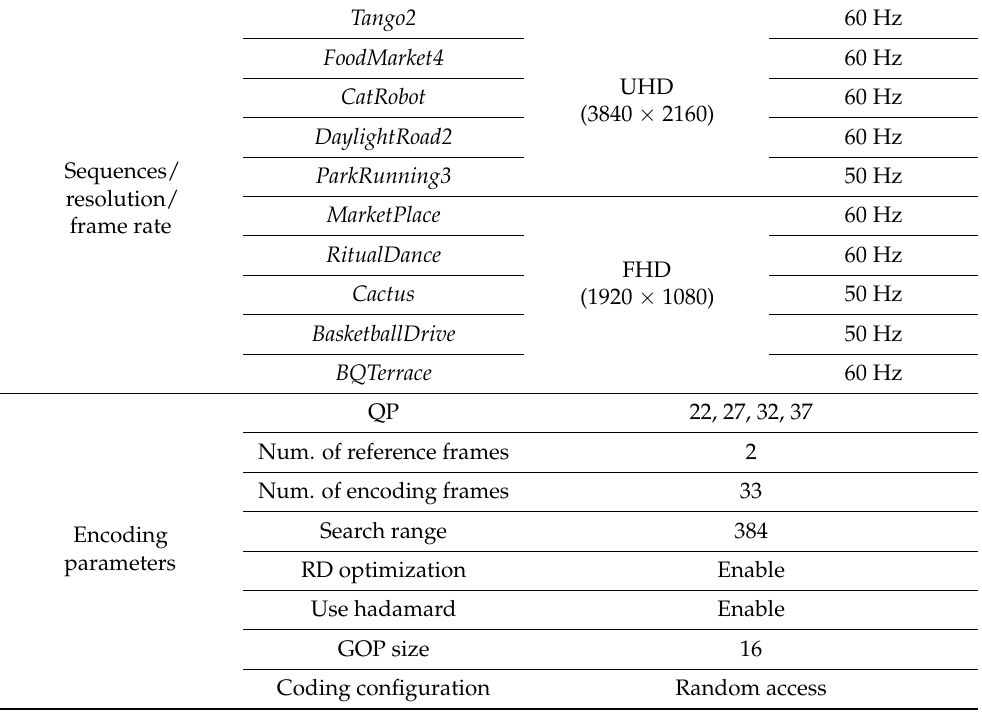
Table 2. Test sequences and encoding parameters used in the experiments.